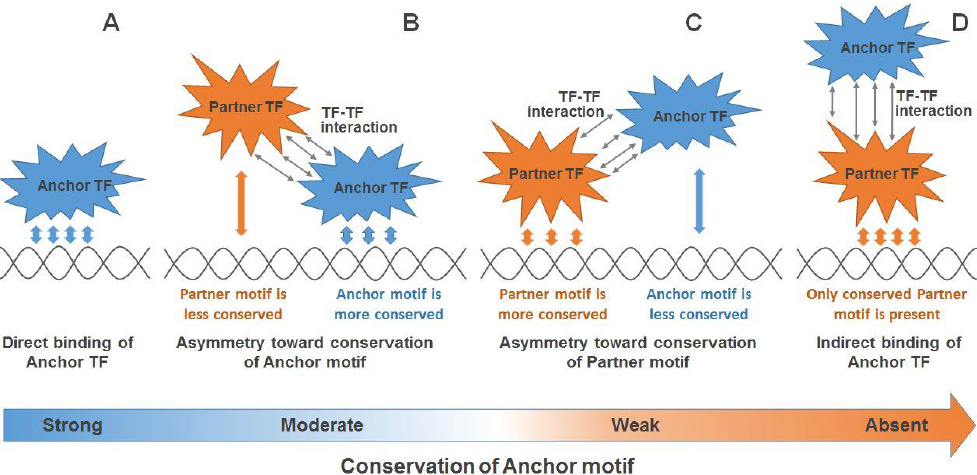
Figure 8. The “ permanent ” model of cooperative binding of an anchor and partner TFs for the explanation of a substantial portion of ChIP-seq data lacking conserved motifs of anchor TFs. Panel ( A ) is in respect to the most conserved motifs of an anchor TF in a ChIP-seq dataset, such motifs are in most cases overrepresented and successively recognized as the canonical motif of anchor TF. However, an anchor TF often participates in TF–TF interactions with multiple partner TFs. Thus, a whole conservation of anchor–partner CE is subdivided between anchor and partner motifs. We propose here two options: an anchor motif preserves the higher conservation than a partner motif ( B ), or an anchor motif has less conserved motif than a partner motif ( C ). Finally, an anchor TF binds to DNA indirectly ( D ), e.g., if a heterodimer of the anchor / partner TFs binds with DNA only through partner TF. The long arrow in the bottom reflects the permanent decrease / increase of the conservation of an anchor / partner motif. Numbers of red / blue arrows between each TF and DNA reflect the conservation of the respective